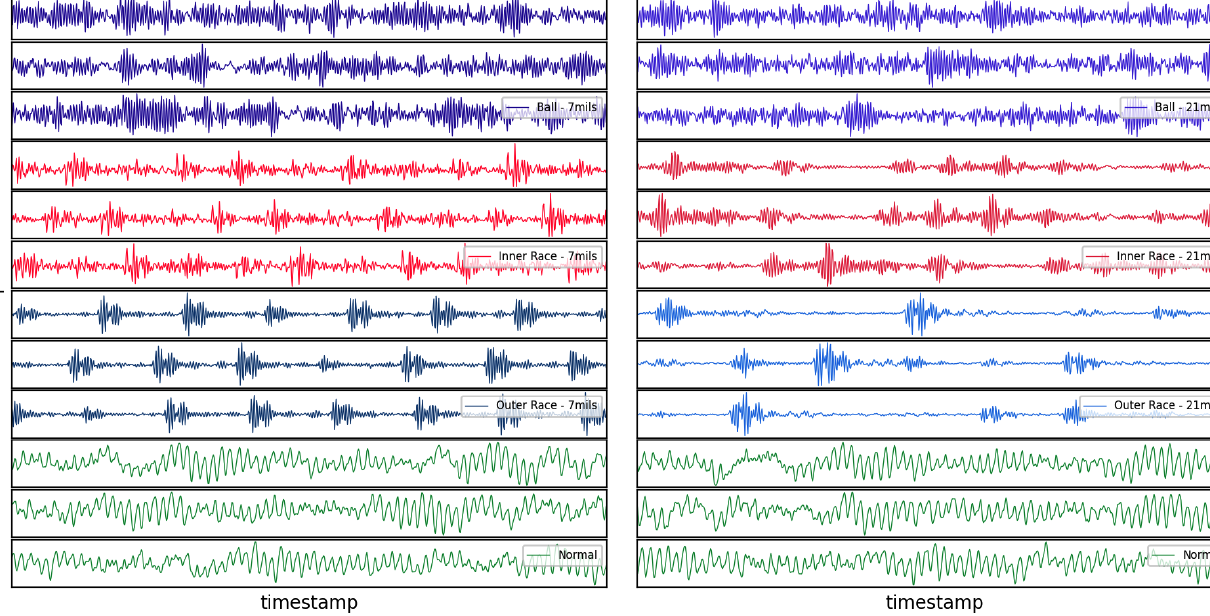
Figure 9. Some real samples associated with different running